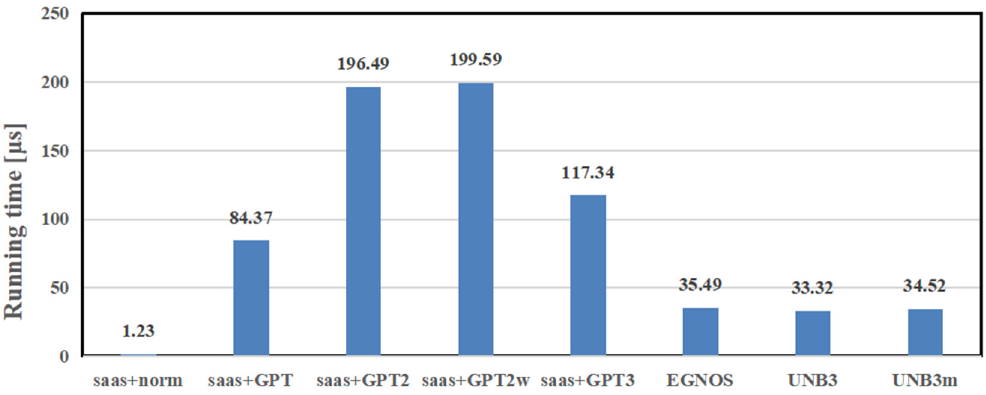
Figure 5. Running time of the eight models (saas+norm/GPT/GPT2/GPT2w/GPT3, EGNOS, UNB3, UNB3m) (unit: μ s).